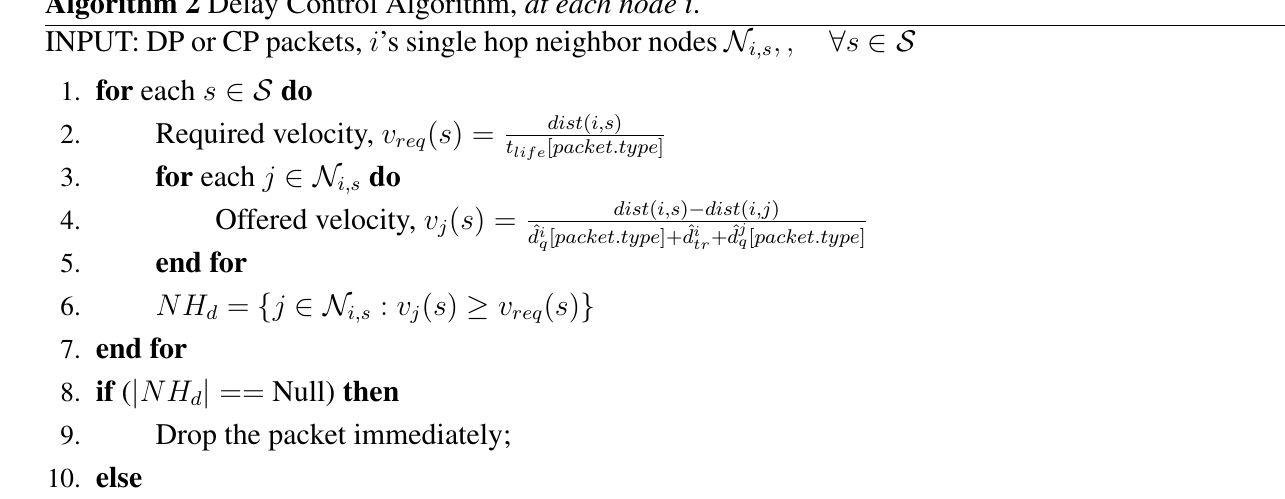
Algorithm 2 Delay Control Algorithm, at each node i